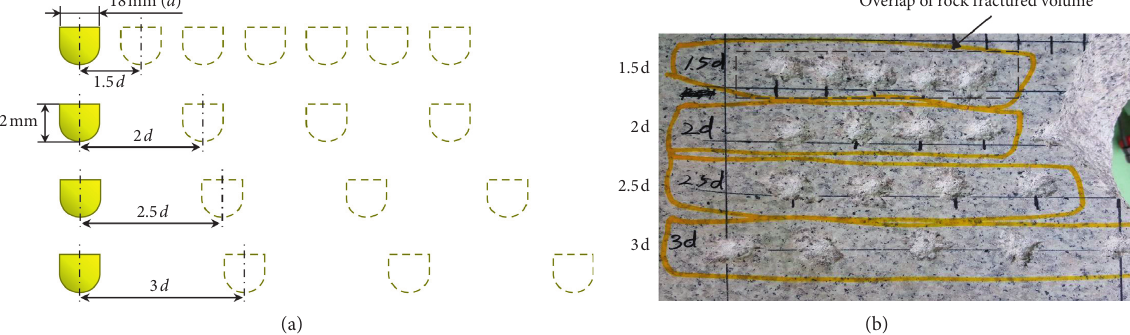
Figure 8: Blow spacing conditions and results of the preimpact test: (a) preimpact test conditions for investigating the effects of rock fracture volume overlap and (b) picture of fractured rock surfaces with blow spacing created during button impact testing.